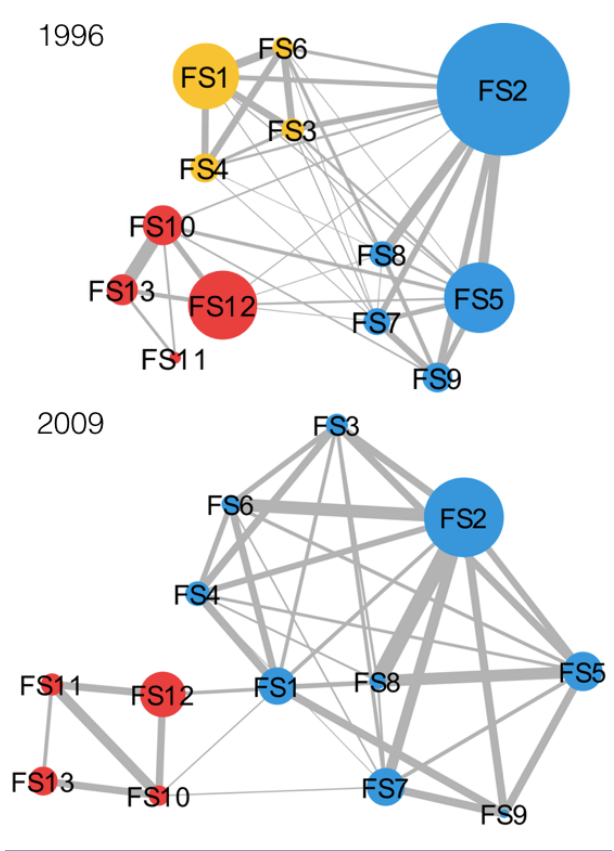
Fig. 3 . Fishing strategies compartments. The size of the node is in relation to the number of fishers practicing the strategy as their primary fishing strategy. The link weight indicates the number of fishers switching between the styles. Note, however, that although the direction of the link is not presented in the graph, the flow between two fishing strategies is not necessarily equal from both directions. In this visualization, for instance, if 8% of fishers with FS1 can switch to FS6, and 44% of FS6 fishers can switch to FS1, the size of the link is in relation to 44% (two overlapping arrows; the weaker link is “hidden below” the stronger